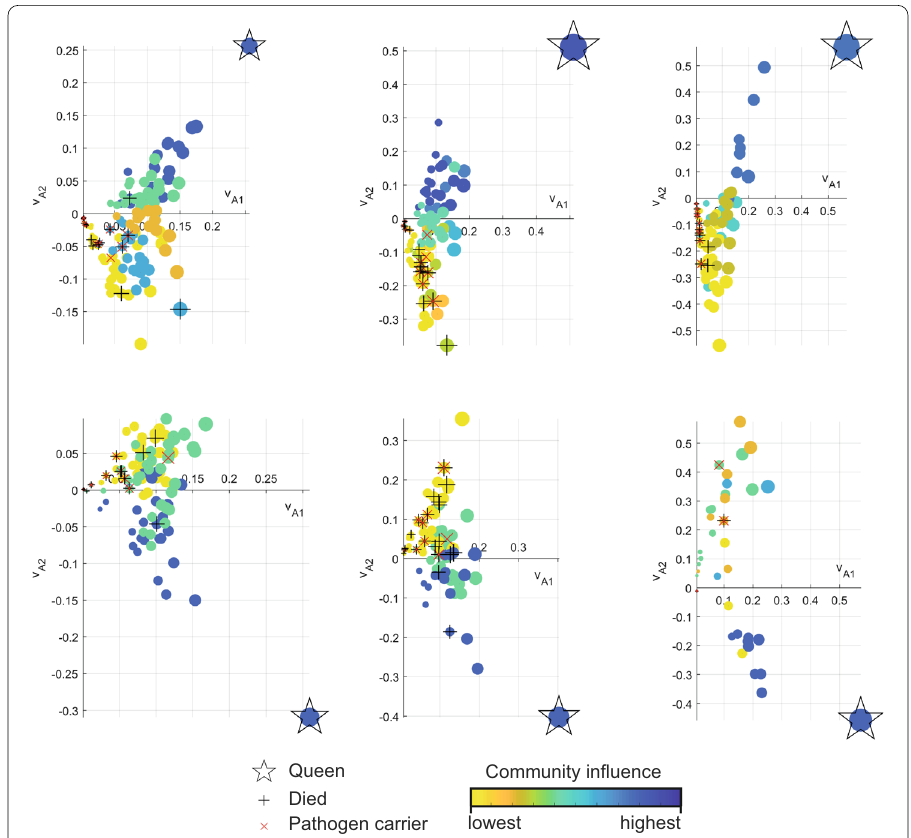
Fig. 5 Community structure from ant colony contact network after pathogen introduction. CDI determined communities are detailed for contact networks of ant colonies infected with a pathogen during a survival experiment [see Stroeymeyt et al. 2018]. Node size is proportional to weighted degree, and colours denote community designation with each community’s influence ranked according to the magnitude of the largest entry of the first eigenvector ( v A 1 ). There are markers indicating the queen ant, ants carrying pathogen at the start of the experiment and ants that died during the experiment. v A 1 and v A 2 are the two dominant eigenvectors of the adjacency matrix composed of pairwise contact